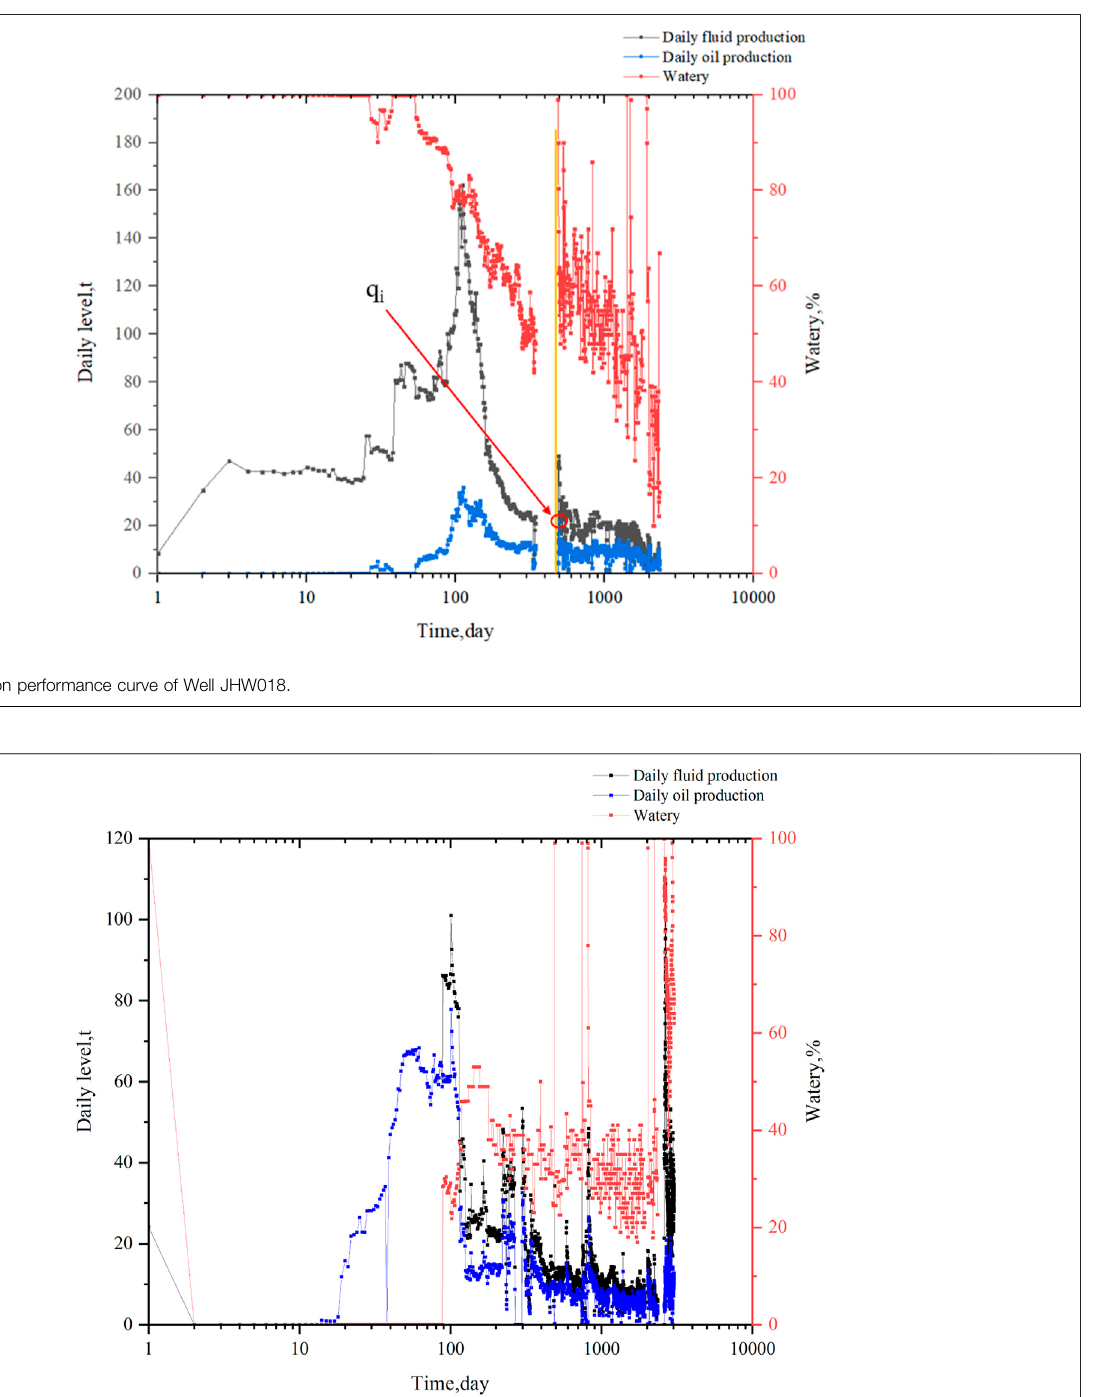
FIGURE 5 | Production performance curve of Well